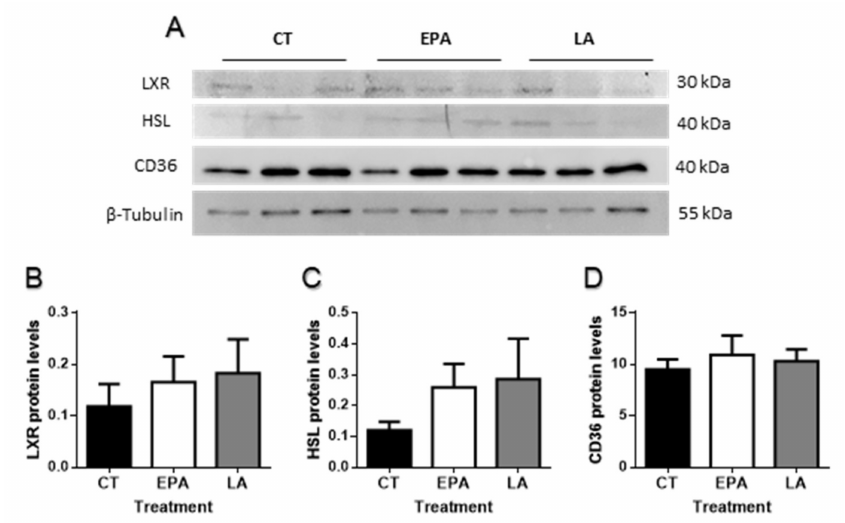
Figure 6. ( A ) Representative Western blots of the transcription factor LXR, the enzyme HSL, the fatty acid translocase CD36, and β -tubulin in the liver of rainbow trout at 6 h after being force-fed with EPA, LA, or vehicle without fatty acid as control. Quantification of protein levels of ( B ) LXR, ( C ) HSL, and ( D ) CD36 normalized to β -tubulin. Data are shown as mean + SEM ( n = 6). Significant di ff erences ( p < 0.05) among treatments were not found. CT: control; EPA: eicosapentaenoic acid; LA: linoleic